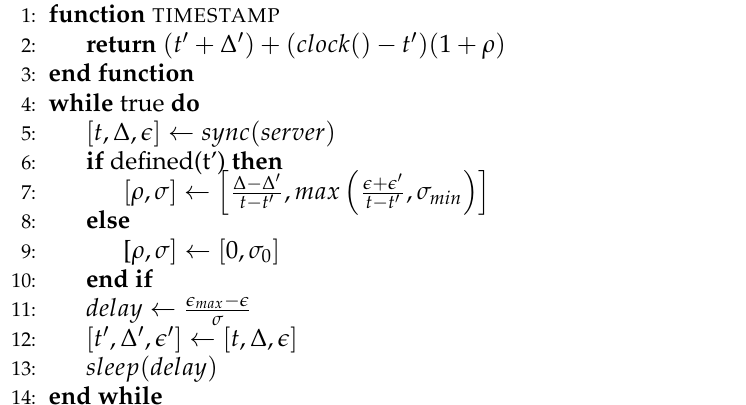
Algorithm 1 The clock synchronization algorithm. The abstract sync function implements the synchronization event. The TIME function implements the SDCk, and returns a timestamp. The abstract clock function returns the value of the hardware clock. The sleep function waits for a given amount of time (measured on the hardware